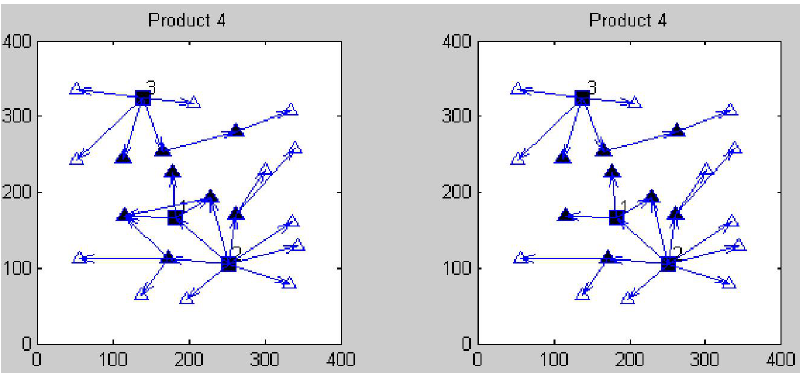
Fig. 8. Transshipment paths (product 4)